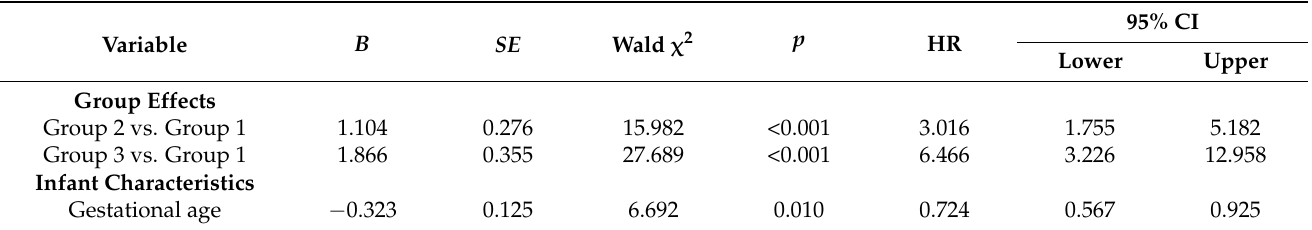
Table 4. Comparison of group effects on crying cessation during heel prick for neonates using Cox regression after adjusting for gestational